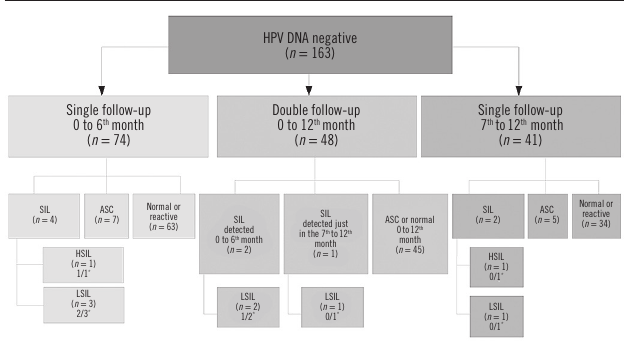
figure 2 – Distribution of HPV-negative by hybrid capture cases for histological or colposcopy evaluation outcome within one-year of follow-up after identification of atypical squamous cells HPV: human papillomavirus; DNA: deoxiribonucleic acid; SIL: squamous intraepithelial lesions; ASC: atypical squamous cells; HSIL: high-grade intraepithelial lesion; LSIL: low-grade intraepithelial lesion; * number of cases with histology/total number of table – Sensitivity, specificity, positive and negative predictive values for HSIL and LSIL Parameters (%)